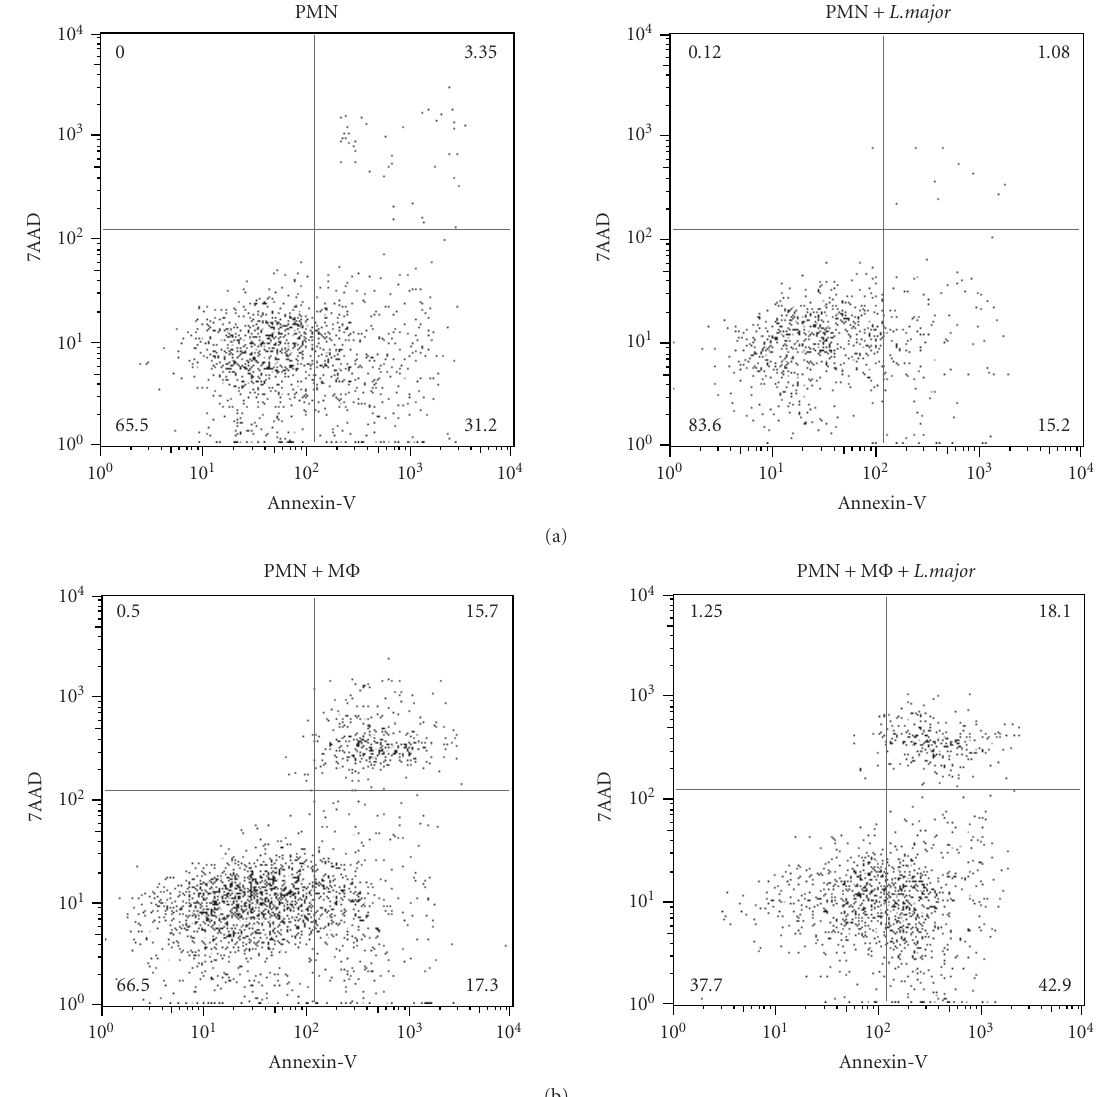
Figure 1: Exposure of neutrophils to L. major decreases spontaneous but not macrophage-induced apoptosis. L. major -recruited C57BL/6 neutrophils (PMNs) and macrophages (M φ ) were isolated from the peritoneal cavity 4 hours or 24 hours after L. major injection i.p., respectively. (a) MACS-purified PMNs were cultured for 24 hours in presence or in absence of metacyclic L. major ( L. major : PMN ratio 1 : 5). Cells were collected, labeled with Annexin-V, 7AAD, and the 1A8 mAb (Ly6G) and PMN apoptosis analyzed by FACS, gating on the 1A8 + PMN population. Early apoptotic cells are Annexin-V + 7AAD − , and late apoptotic/necrotic cells are Annexin-V + 7AAD + . (b) PMNs were cultured in presence of fixed M φ (PMN : M φ 1 : 2) with or without parasites, and 24 hours later, neutrophils were analyzed as in A. Data are representative of three independent